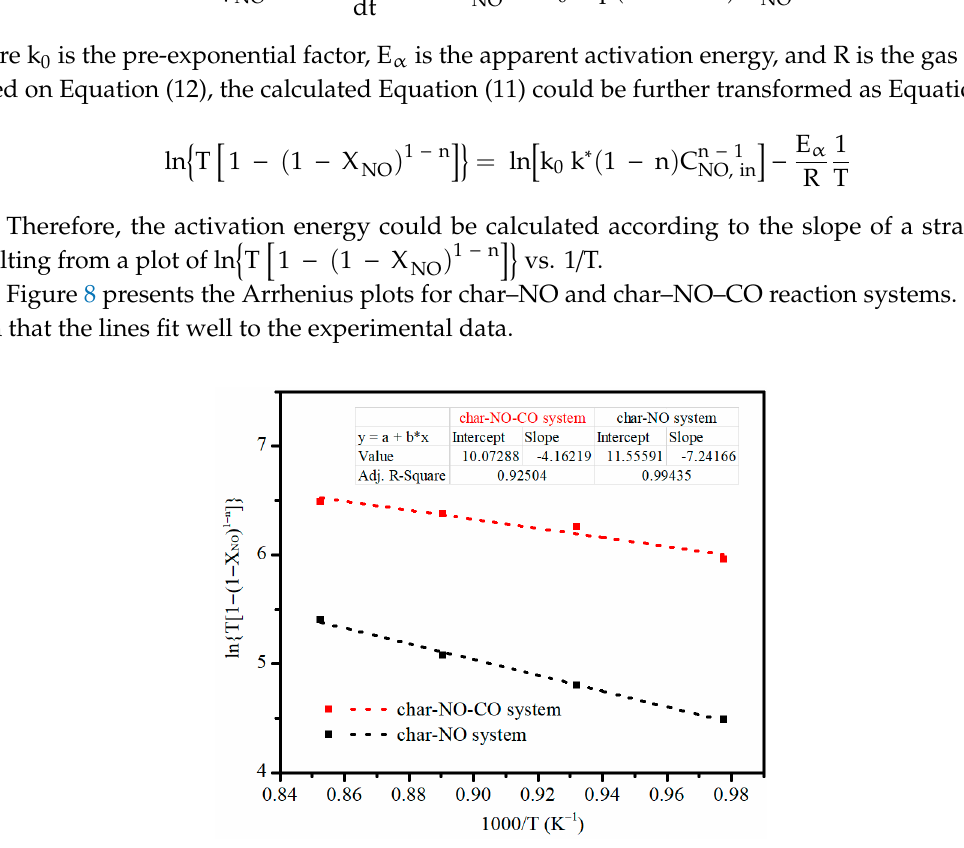
Figure 8. Arrhenius plots for NO reduction with rice husk char.